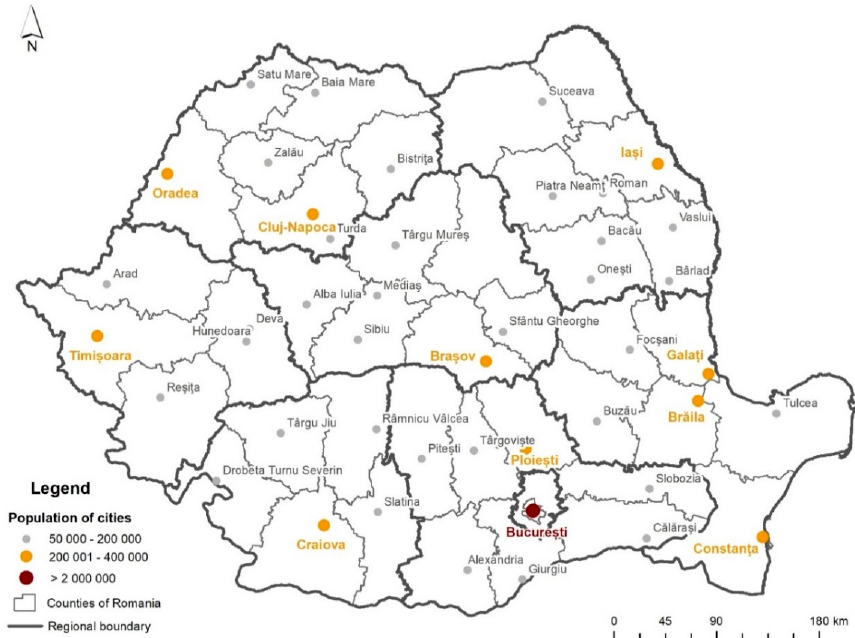
Figure 1. The Romanian cities with population exceeding 50,000 inhabitants.